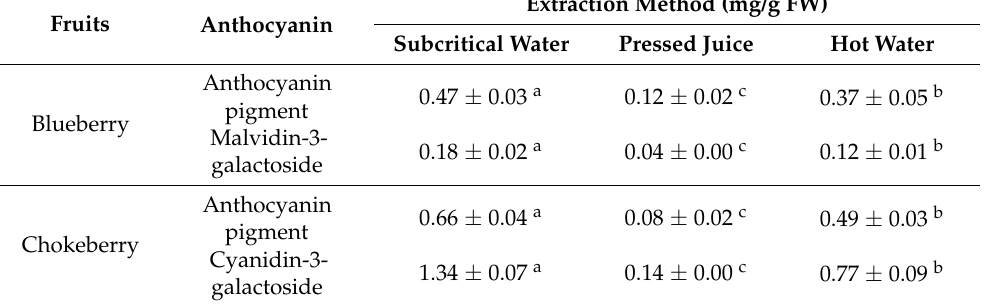
Table 2 indicates that the concentration of anthocyanin at the optimal SWE condition was about 4.5 times higher than that of pressed juice (0.04 ± 0.00 mg/g FW) and about 1.5 times higher than that for the extract obtained using hot water (0.12 ± 0.01 mg/g FW). The subcritical water at 100 ◦ C or higher had a lower dielectric constant than that of water at 60 ◦ C, thus affecting the extraction efficiency of anthocyanin. Table 2. Comparison of the efficiency of extracting anthocyanin from blueberries and chokeberries according to the extraction conditions ( n = 3). Fresh weight (FW). Means in a row followed by same superscript letters are not significantly different according to Duncan’s test at p < 0.05. Data are mean and SD values.